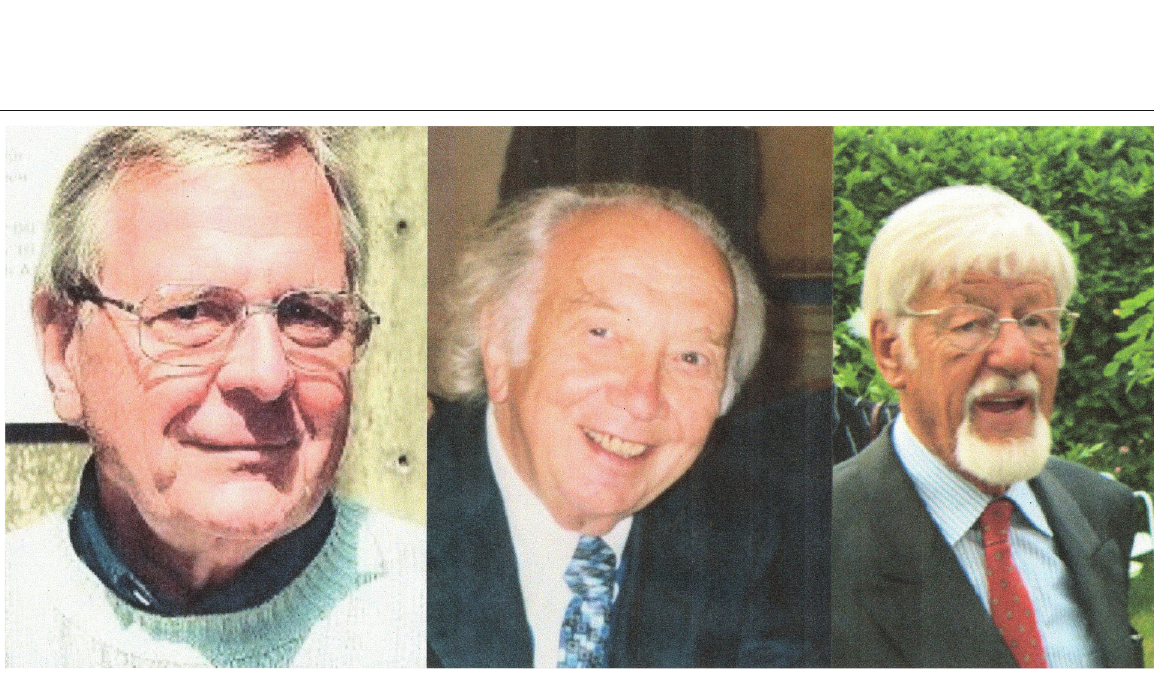
Fig. 5 a , b and c Dieter Scheffner, Franz Josef Schulte and Hermann Doose, pioneers of the neuropediatric society GNP in